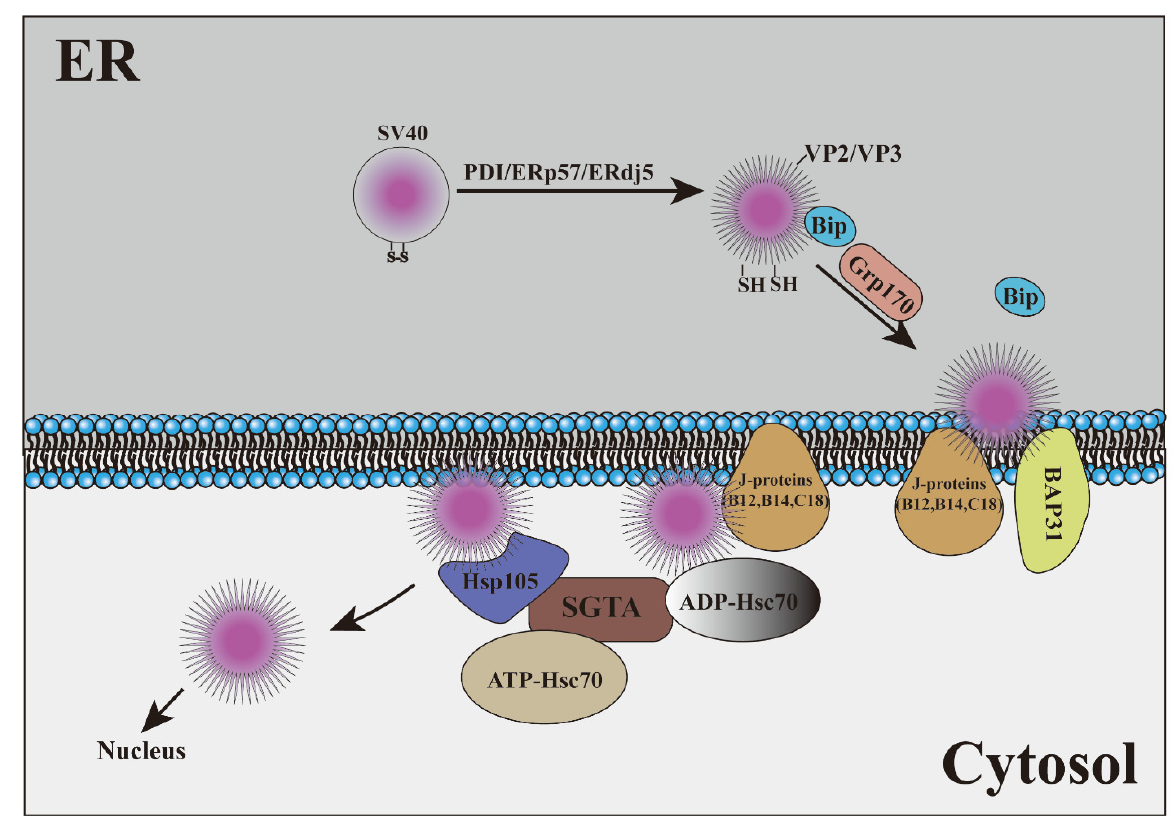
Figure 4. SV40 hijacks ERAD as a transport mechanism.